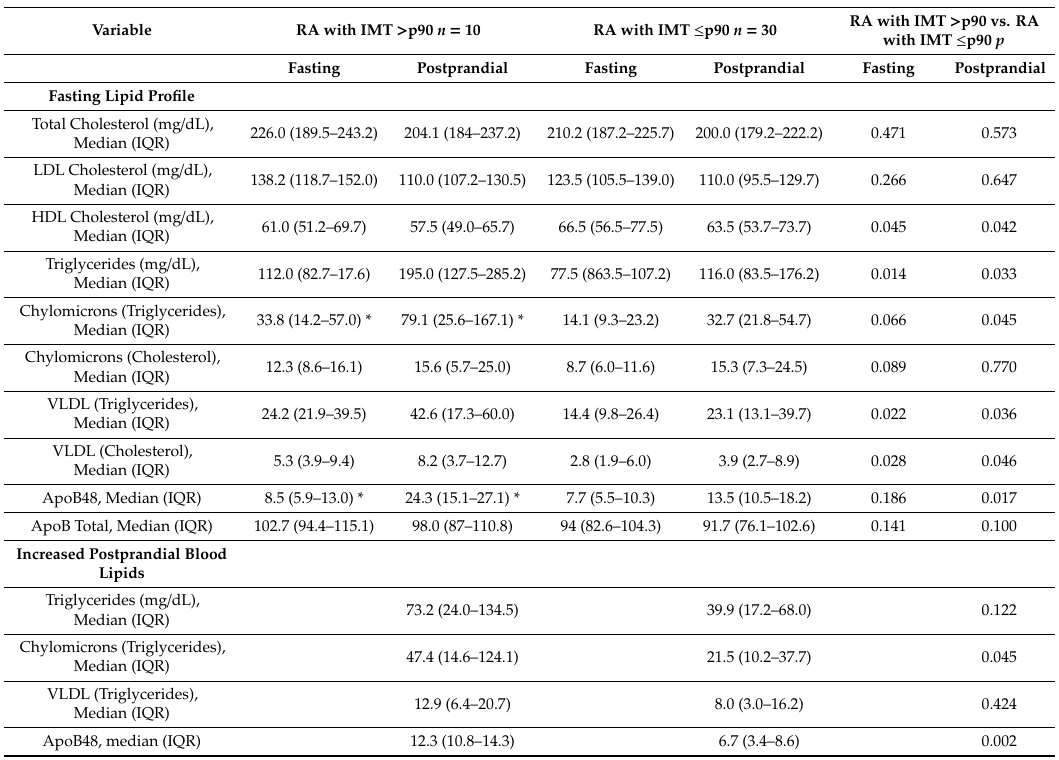
Table 4. Lipid profile and carotid ultrasound in RA patients according to cIMT.